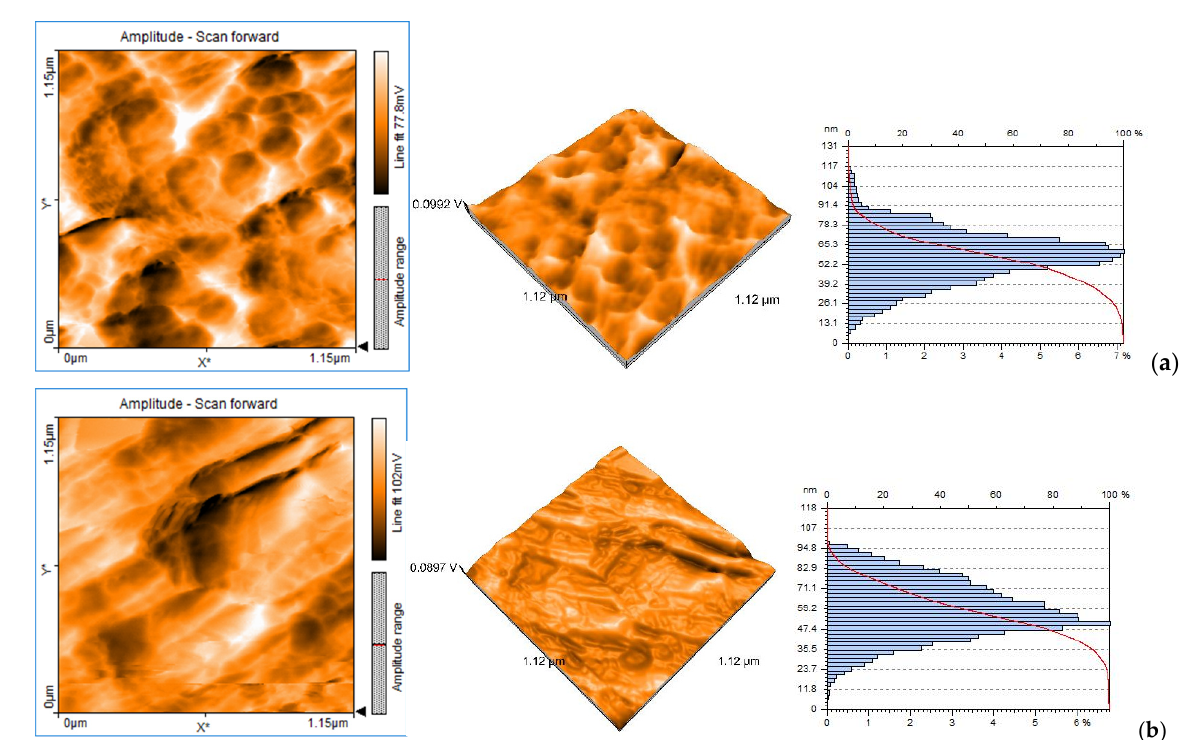
Figure 4. Two-dimensional and 3D AFM surface images and particle size distribution for FTO-TiO 2 film ( a ) and FTO-TiO 2 -CuMnO 2 film ( b ).